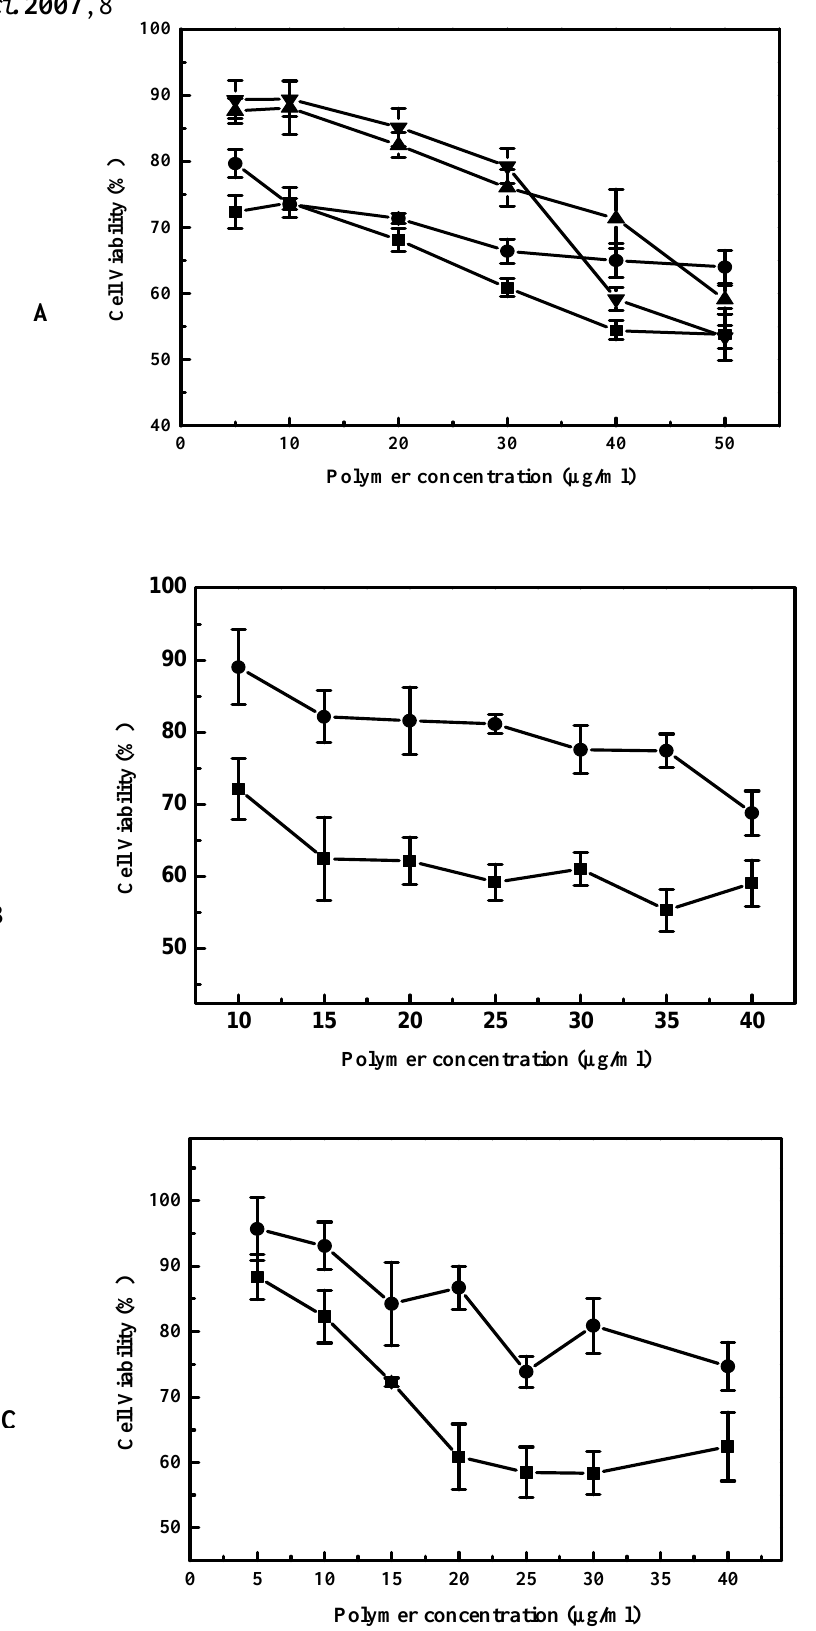
Figure 6. Cytotoxicity of cross-linked PEIs for B16F10, 3T3 and 293T cells. (A) Cytotoxicity of cross-linked PEIs and 25 k-Da PEI for B16F10 cell. - ■ -: 25 k-Da PEI; - ● -: GDMA-PEI 2000-4h; - ▲ -: BDDA-PEI 2000-4h; - ▼ -: EGDMA-PEI 2000-2h. (B) Cytotoxicity of cross-linked PEIs for 3T3 cell. - ■ -: 25k-Da PEI; - ● -: EGDMA-PEI 2000-4h. (C) Cytotoxicity of cross-linked PEIs for 293T cell. - ■ -: 25 k-Da PEI; - ● -: EGDMA-PEI 2000-4h. ( N= 8, error bars represent standard